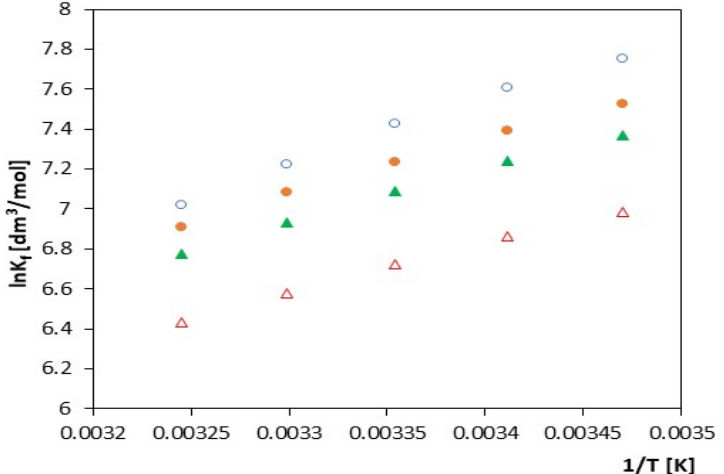
Figure 3. The plots of dependence of the lnK f (dm 3 /mol) formation constant in the T (K) function for α -cyclodextrin with all studied salts: ∆ - trans -cinnamic acid; (cid:78) - trans-p -coumaric acid; • - trans -caffeic acid; and - trans -ferulic (cid:35)